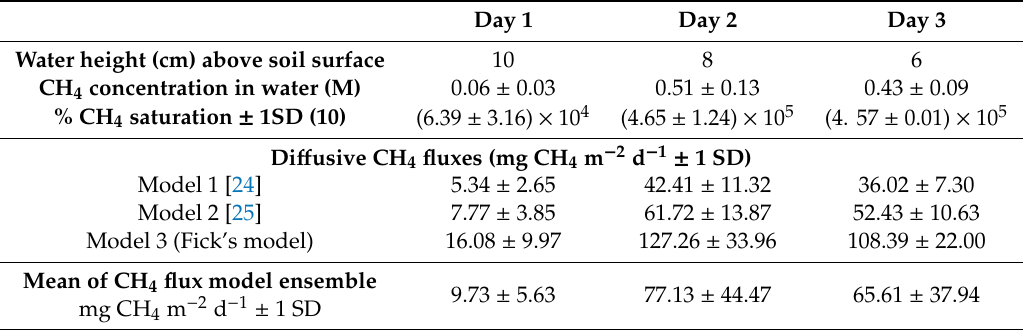
Figure 7. Mean daily values of CH 4 fluxes plotted vs. cumulative rainfall calculated considering 2 days ( a ), 10 days ( b ) or 30 days ( c ) preceding the date of gas sampling. P represents the statistical significance of the fitting curve (solid line). Equation panel b: y = 0.18 × x 1.16 ; equation panel c: y = 40.2 + 16.7 / (1 + e ( − (x − 94.4) / 6.08) ). Table 2. Estimates ( ± 1 SD, n = 10) of CH 4 concentration in pond water, % saturation of CH 4 in water, CH 4 di ff usive fluxes determined with three di ff erent models, average ( ± 1 SD) of the ensemble of the three models’ results. Data were calculated for three consecutive days of sampling in June